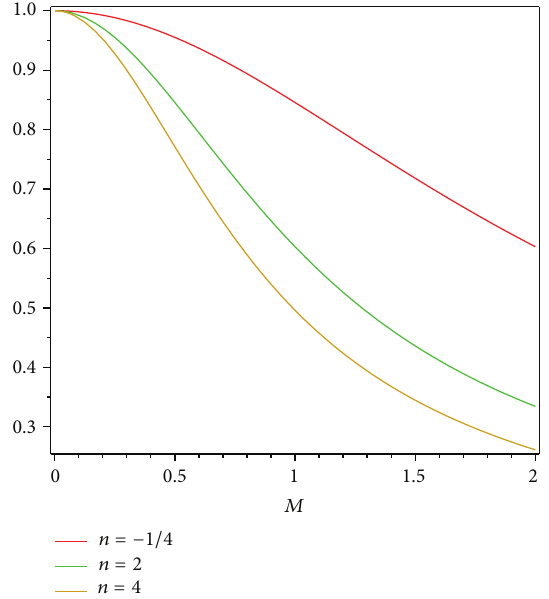
Figure 4: Efficiency 𝑓(𝑥) = √𝑥 + 1 as given in solution (21) in a fin with varying values of 𝑛 .